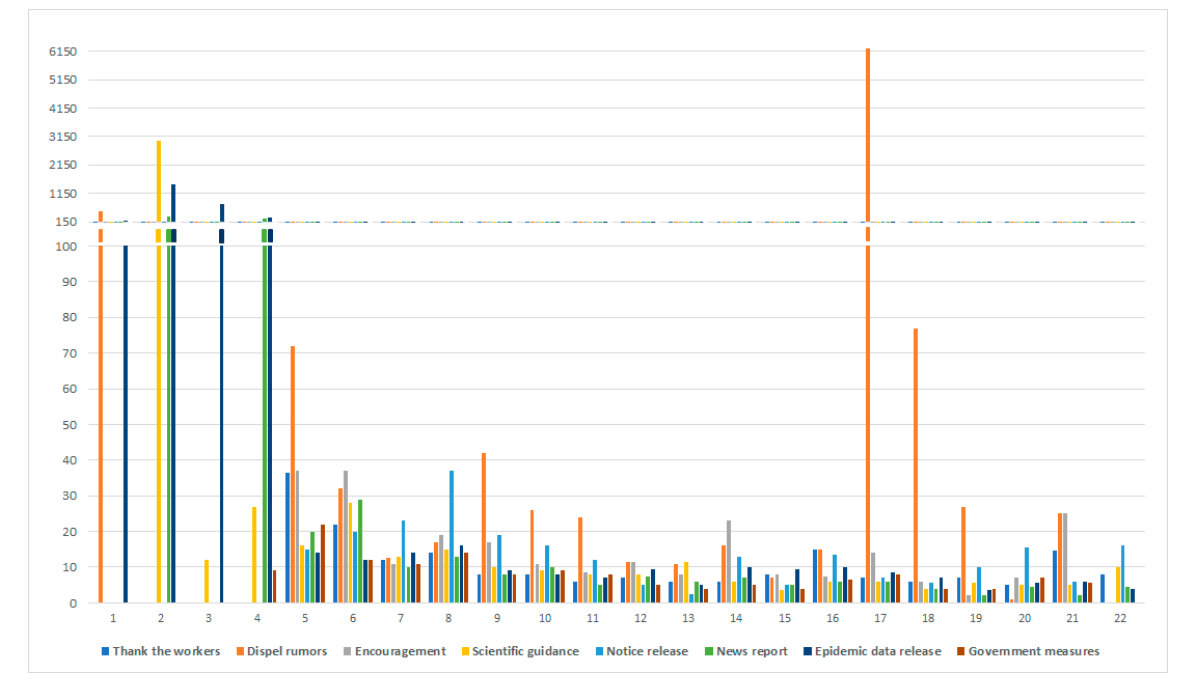
Figure 2. Median Repost count for 8 categories of content.